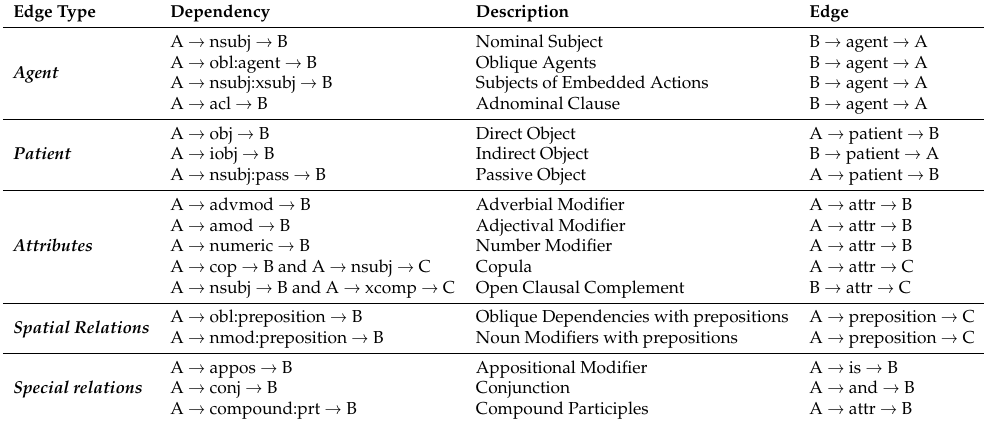
Table 2. A summary of the edge creation protocols based on dependency